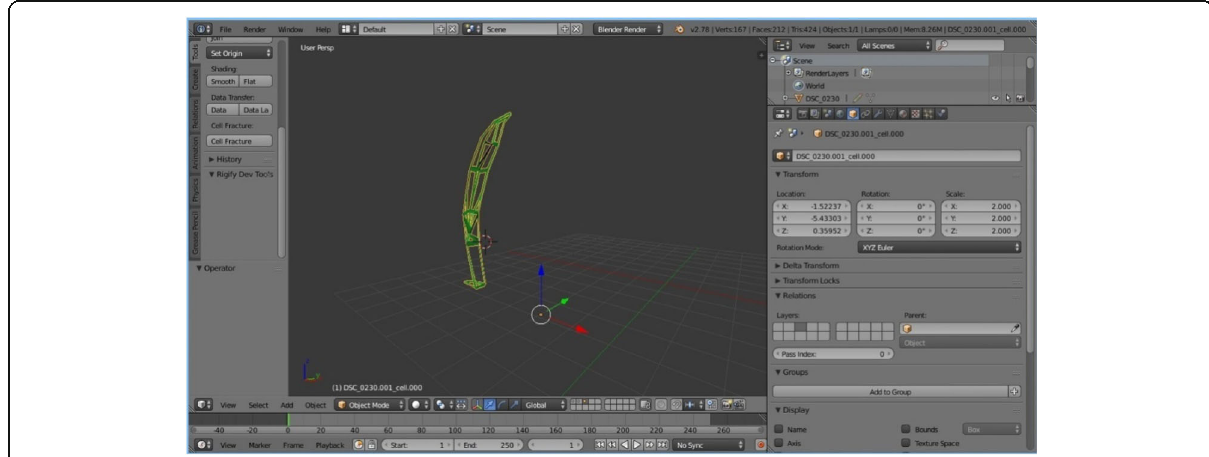
Fig. 12 The model of a candelabra obtained in